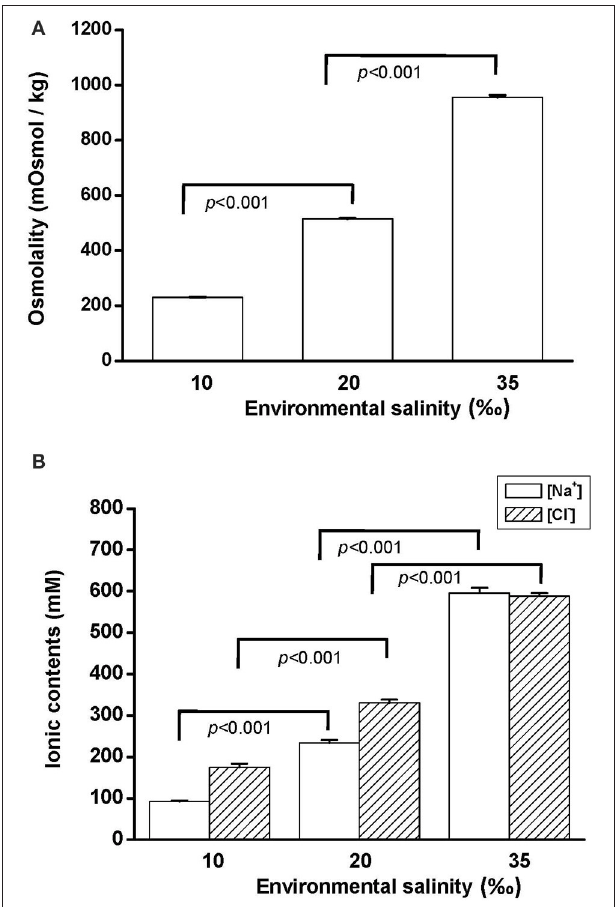
FIGURE 1 | Salinity effects on (A) osmolality and (B) [Na + ] and [Cl − ] of the hard clam hemolymph. Statistical analysis was performed with one-way ANOVA followed by Dunnett’s test. The 20 ‰ SW group was used as a control. p < 0.05 was considered statistically significant. Values are means ± SEM. ( N =